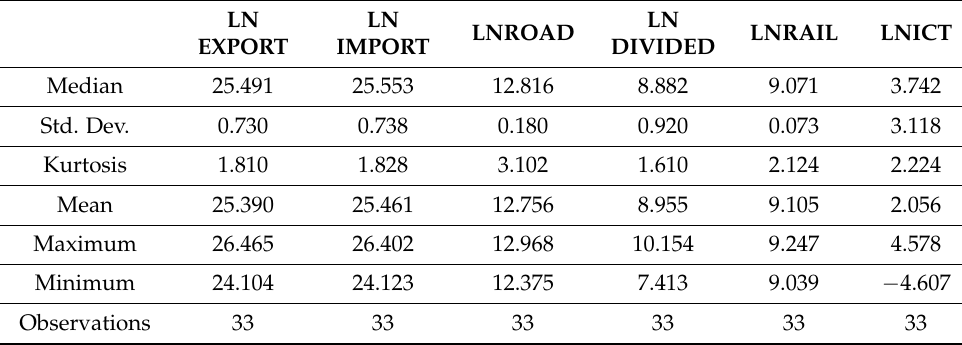
Table A1. Table below show descriptive statistics for variables